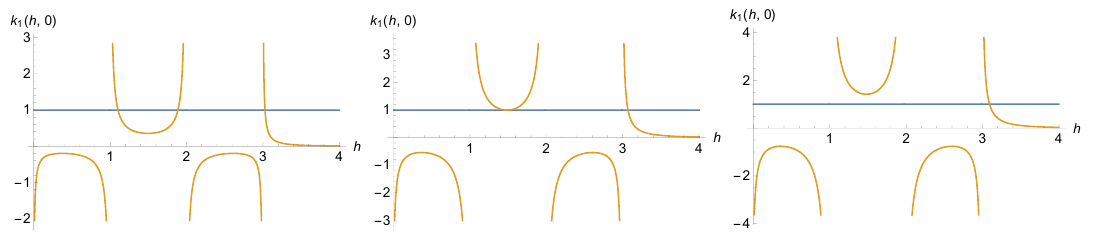
Figure 13. Plots of k 1 ( h; 0) at d = 3 (cid:0) (cid:15) for, from left to right, (cid:15) = 0 : 01, (cid:15) = 0 : 02819, and (cid:15) = 0 : 04. On the left panel, the intersections with the blue line correspond to h 0 , h q and h 1 . On the middle panel, h 0 and h q have merged, and on the right panel only h 1